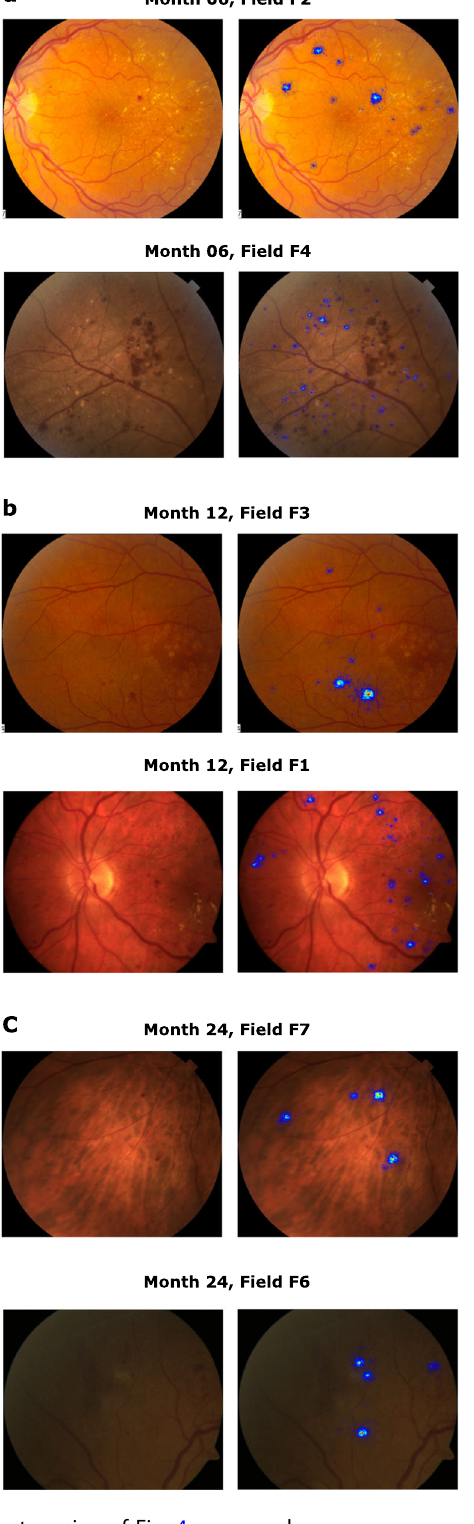
The correct version of Fig. 4 appears above.